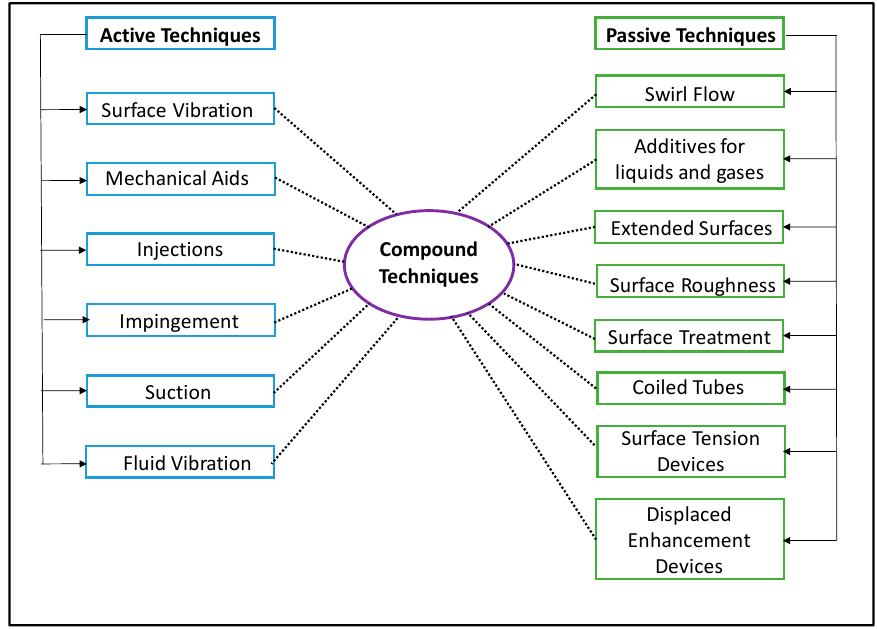
Figure 2. Phase change heat transfer (PCHT) enhancement methods with active and passive techniques.